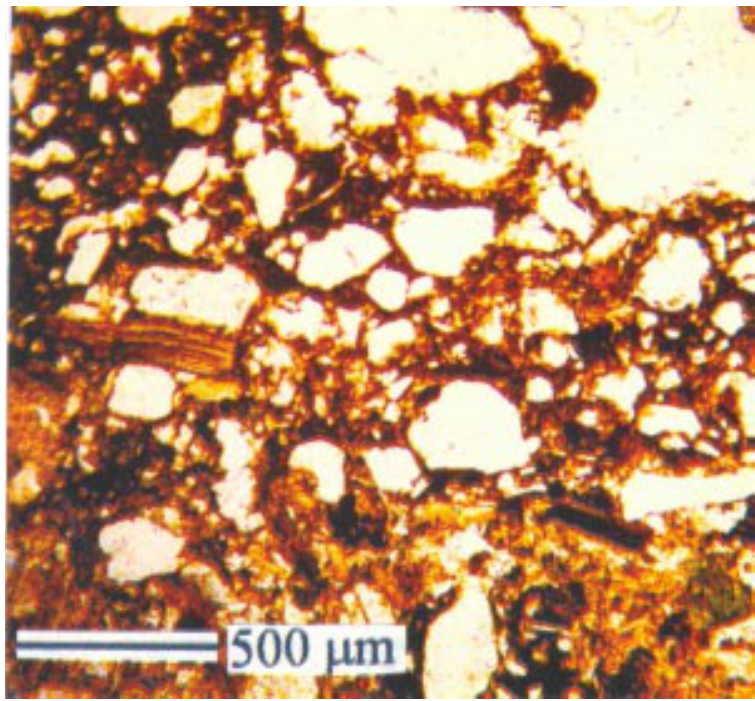
Figura 6. Micrografia do horizonte Ap do Bruzizém Avermelhado. Aspecto do padrão de distribuição relacionado quito-enauli-porfírico.